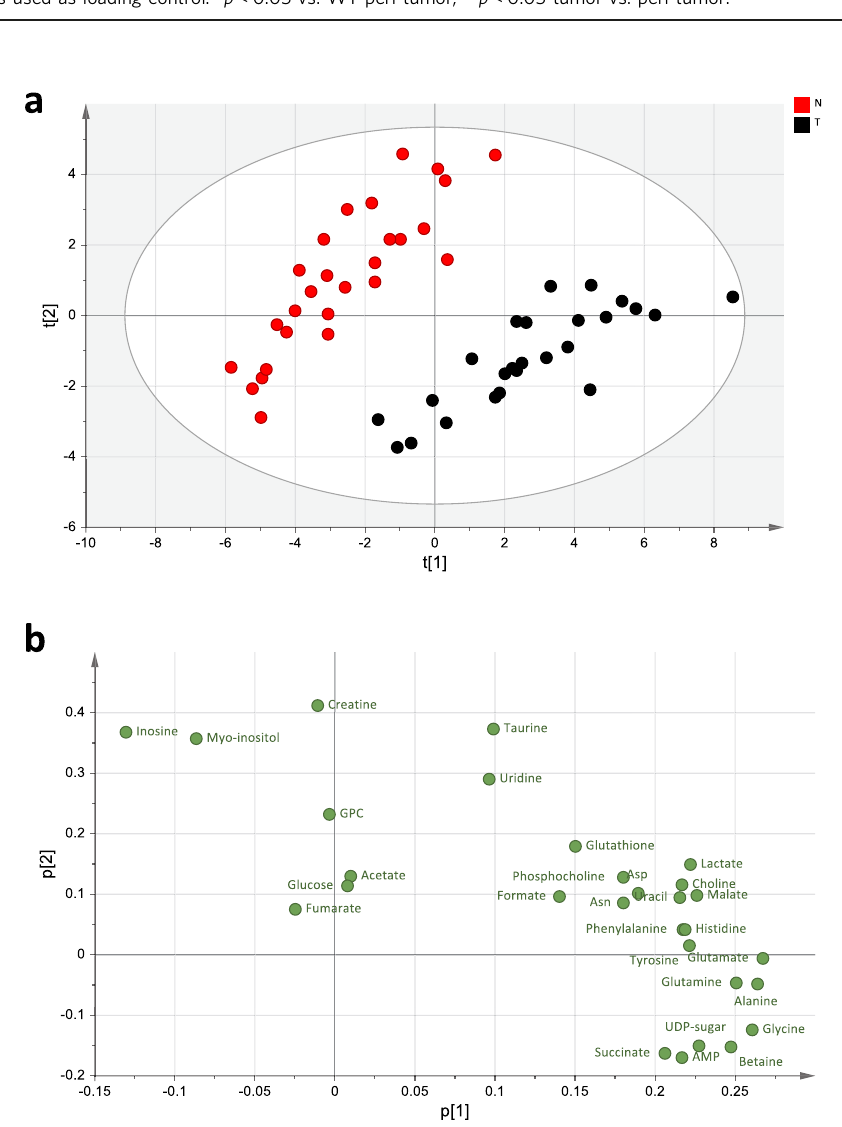
Fig. 4 Tumor and peri-tumoral tissues have distinct metabolic states as revealed by NMR spectroscopy analysis. a Principal component analysis (PCA) score plot from NMR data for total fatty acids ( R 2 = 75.9% and Q 2 = 41.7%). At least seven independent biological replicates of colon tissue from peri- tumorous (red) and tumorous (black) tissues were included. b Plot showing the individual metabolites driving the separation among the tissue types (loadings), with the variables (i.e., metabolites) represented in green circles (Asp = aspartate and Asn =